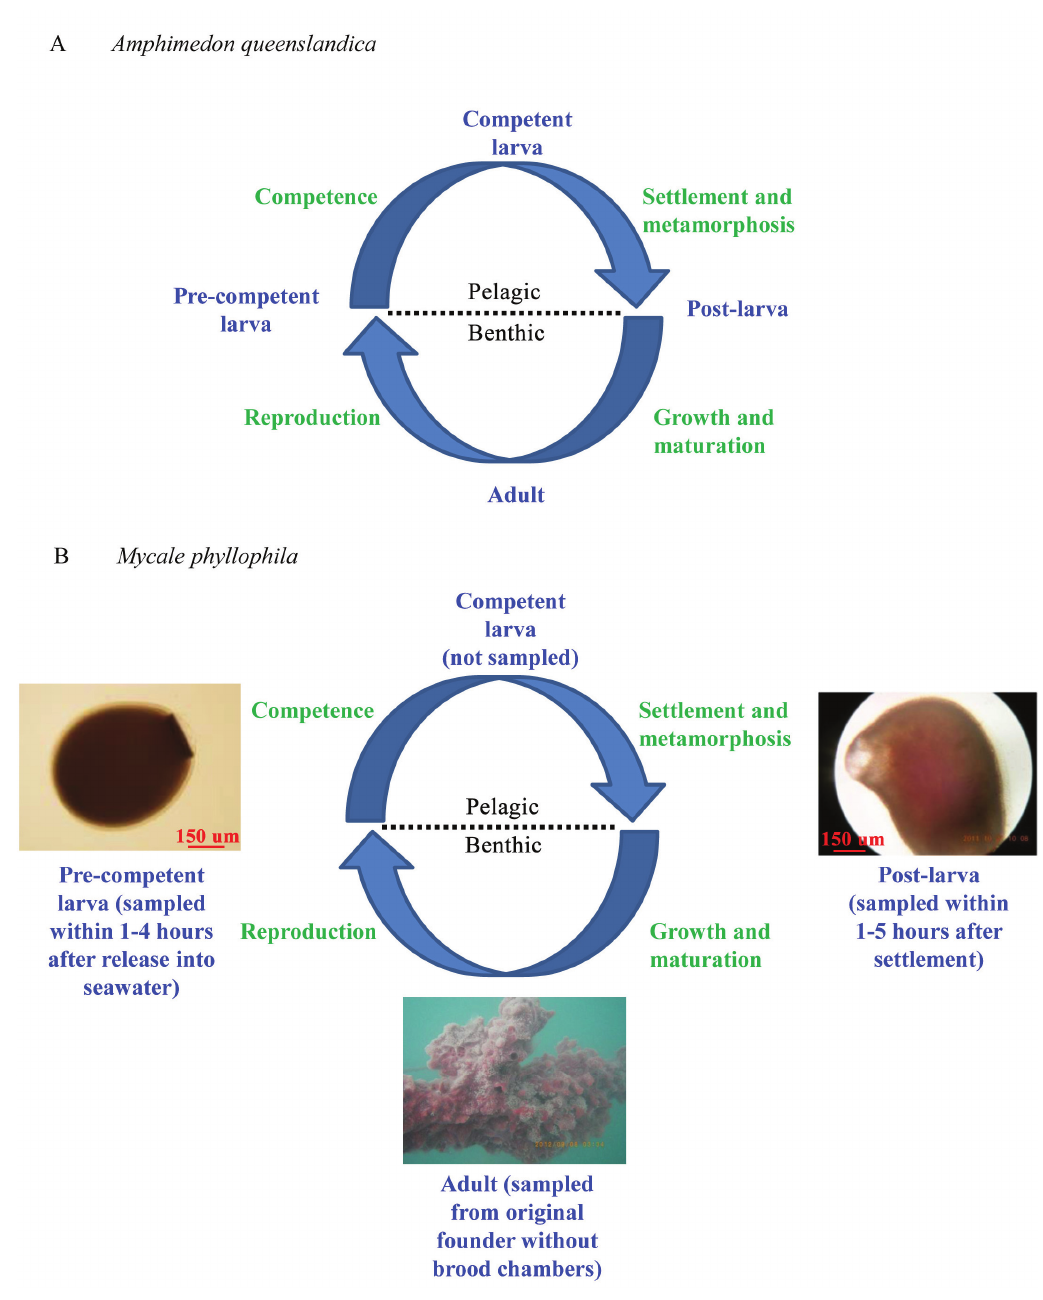
Figure 1. The life cycles of A. queenslandica and M. phyllophila . ( A ) The life cycle for A. queenslandica is from Conaco et al. ([30]: Figure 1A); ( B ) Specific sampling times (in parentheses) and photographs are provided for the three represented life cycle stages of M. phyllophila